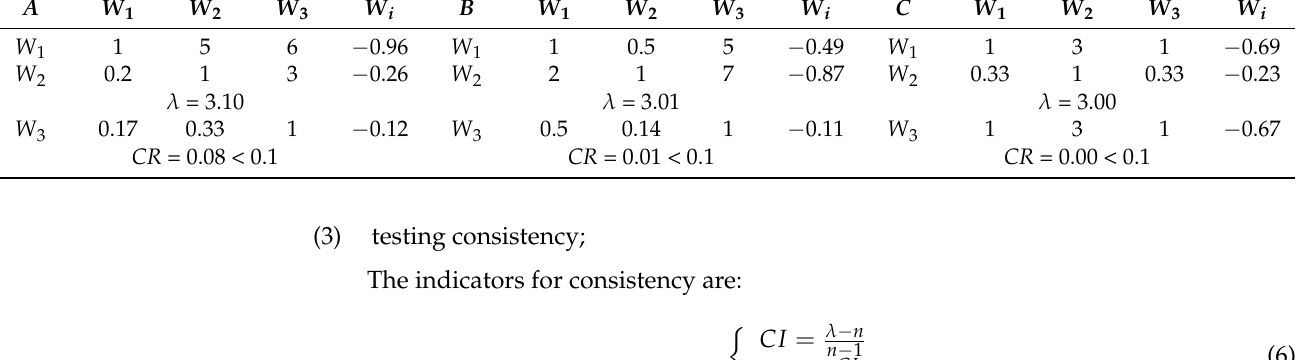
Table 7. Evaluate the judgment matrix, relative weight and consistency judgment list of the objec-